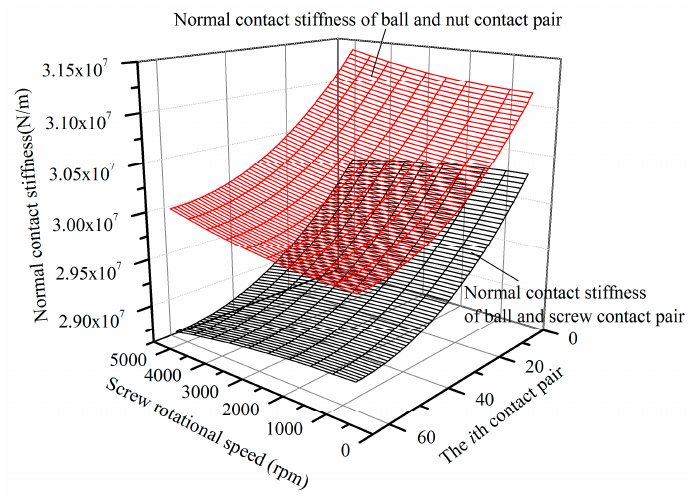
Figure 17. Variation of the normal contact stiffness with the screw speed and the contact position.